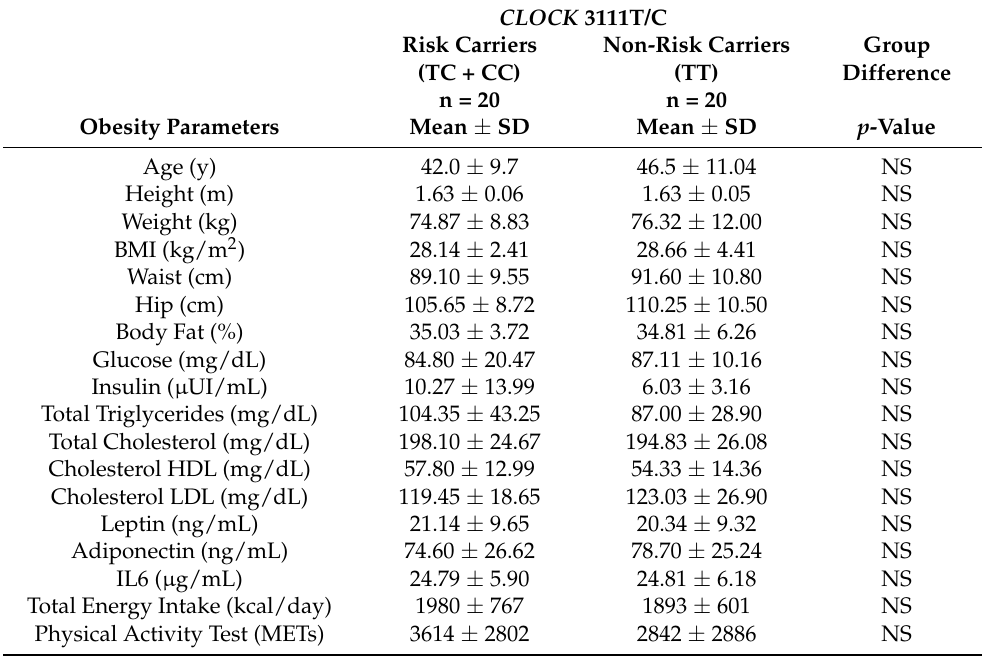
Table 1. General characteristics of the study population. Data are presented as mean ± SD. NS indicates p > 0.1. * One subject (TT carrier) did not complete the weight loss program and, thus, was excluded for the analysis related to weight